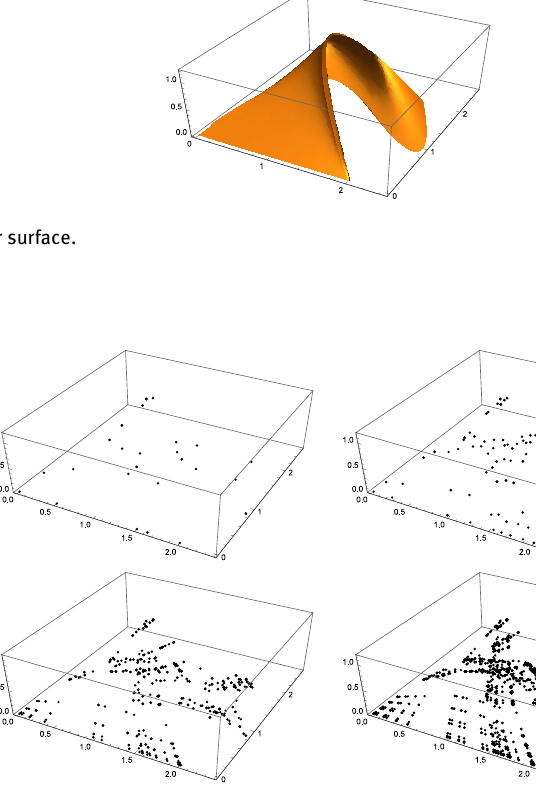
Figure 4: The control points from the first four iterations of